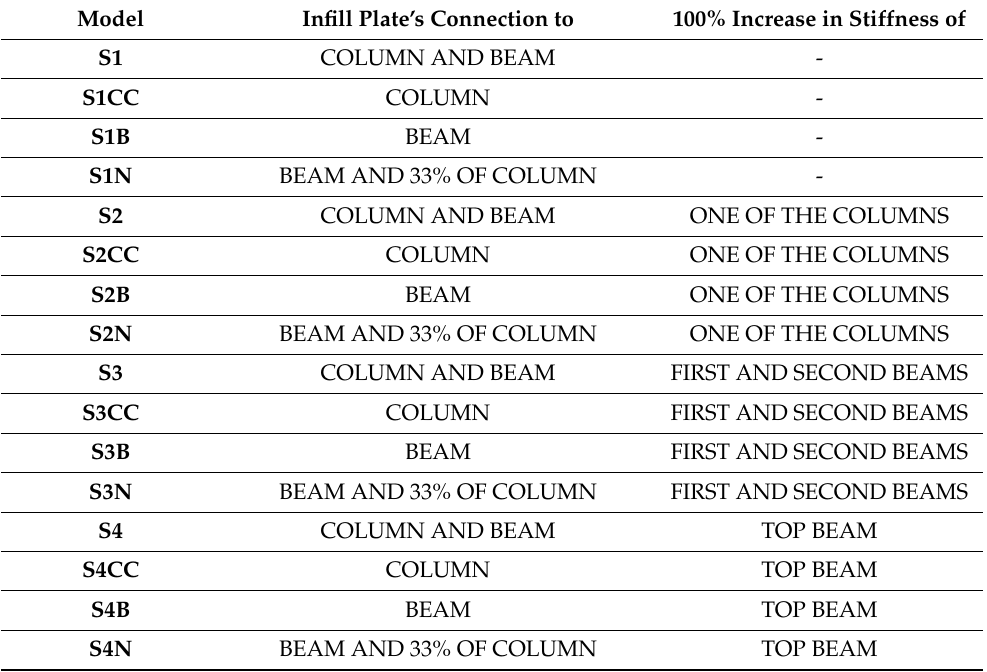
Table 1. Models and changes in boundary